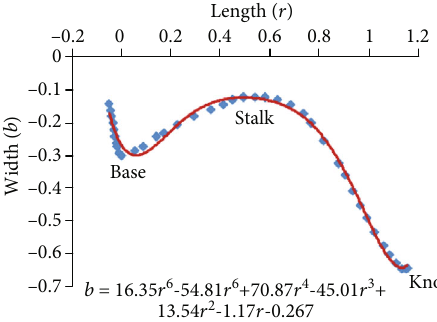
Figure 12: Curve fi tting along the line L